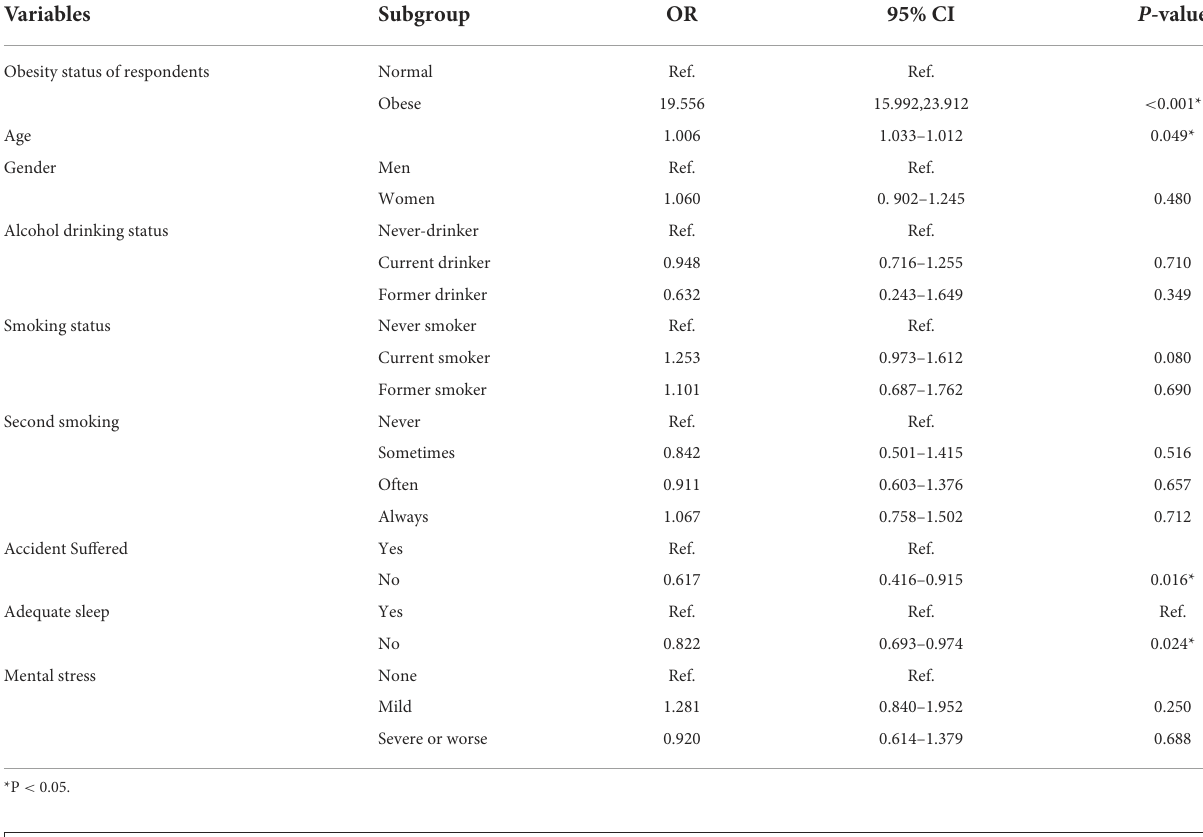
TABLE 2 Factors associated with obesity perception in close relatives among adults in Chongqing,